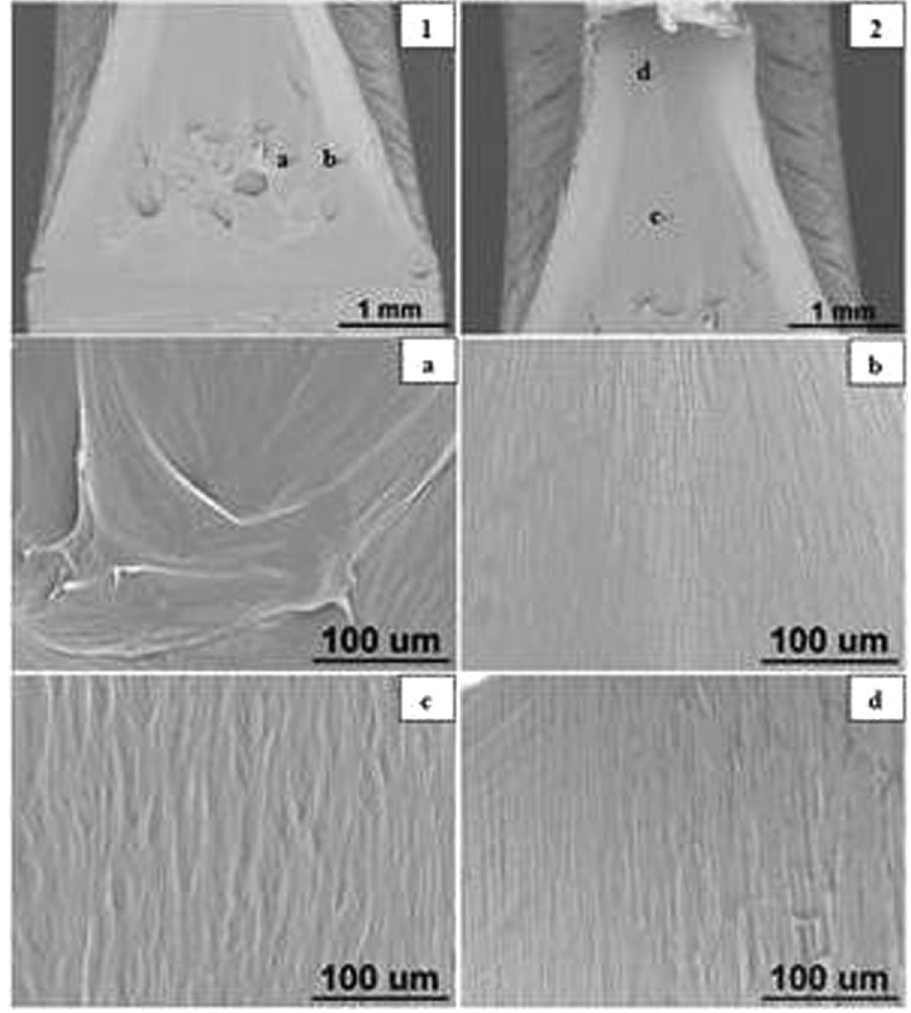
Figure 16. SEM images of sharp crack HDPE fracture surfaces at 5 mm/min (1) crack tip at the bottom, crack propagating from bottom to top; (2) top of propagation at 25